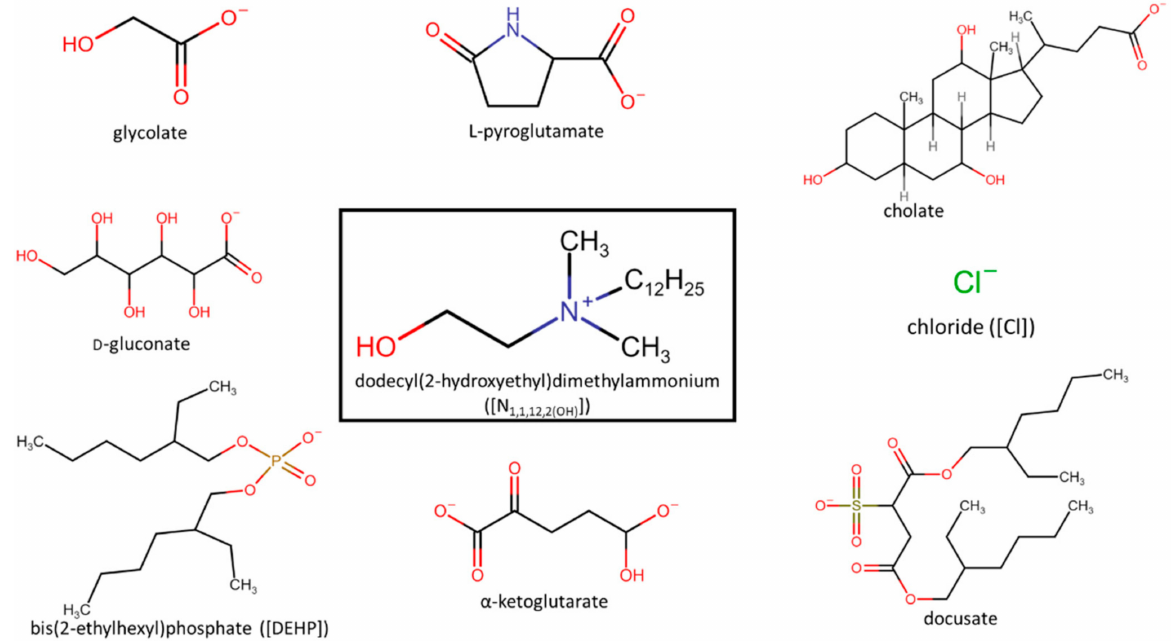
Figure 7. Ionic liquids studied by Kaczmarek et al.